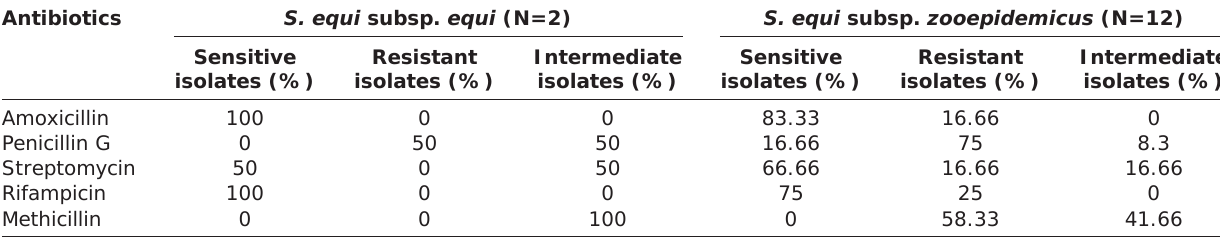
Table-5: Results of antibiogram for S. equi subsp. equi and S. equi subsp. zooepidemicus .